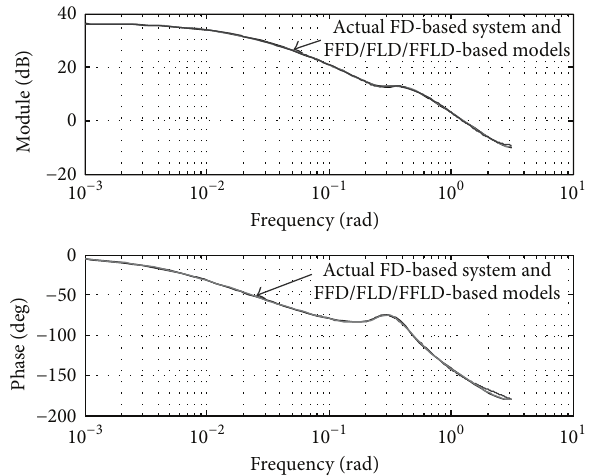
Figure 2: Bode plots of the actual system versus FFD/FLD/FFLD- based fractional Laguerre models; Example 16.